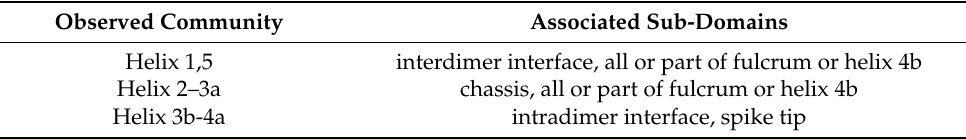
Figure 4. Dynamical network models of capsid-incorporated dimers. ( a , b ) Representative model for apo-form AB and CD dimers. ( c , d ) Representative model for AT130-bound AB and CD dimers. Models calculated in triplicate (Figure S2) based on ensembles of one million conformers collected over 20 µ s of cumulative sampling. Models shown colored by communities and weighted by the extent of correlation in residue motions. Visualization created with NetworkView [35]. Five major communities encompass helix 1,5 of each half-dimer (purple and red), where helix 5 forms the interdimer interface, helix 2–3a of each half-dimer (blue and green), which are part of the chassis sub-domain, and helix 3b-4a of both half dimers (orange), called the spike tip. The remainder of the fulcrum sub-domain (black arrow) participated in either the helix 1,5 or helix 2–3a community within the same half-dimer. Significant differences between network models involved the fragmentation of these five major communities, particularly 2–3a and 3b-4a, denoted by light and dark variations on each color (light and dark blue, green, and orange). A small community in helix 1 was also occasionally observed (yellow). Table 2. Major communities identified in dynamical network